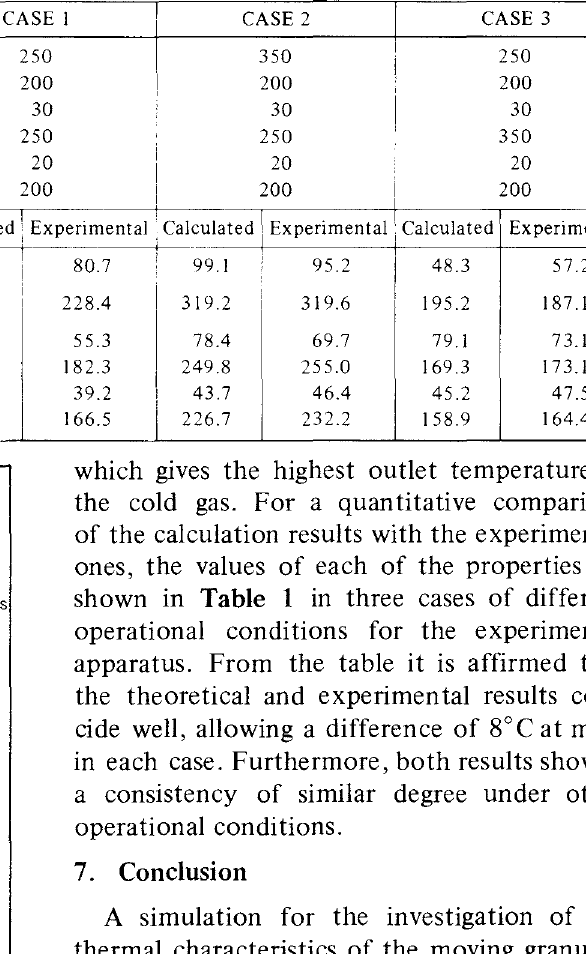
Table l Comparison of the calculation results with the experimental ones